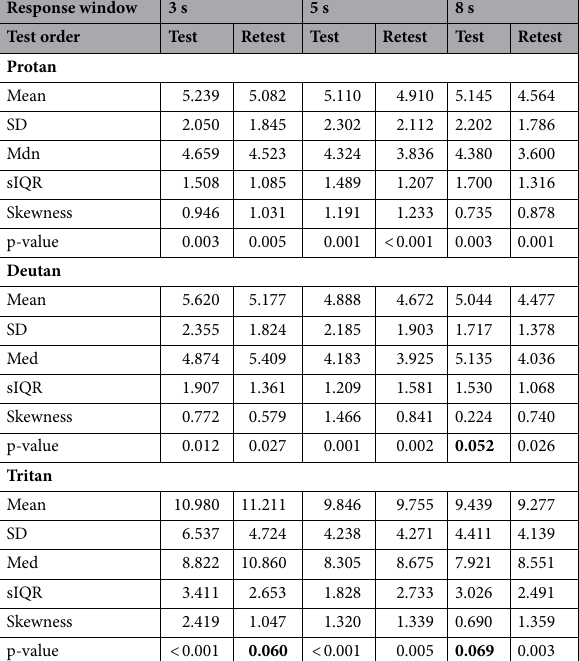
Table 1. Descriptive statistics of the Trivector measures (10 –5 u ′ v ′ units) for 3-s, 5-s and 8-s response windows, for test and retest, for the sample of normal trichromats (N = 30): Mean, standard deviation (SD), median (Mdn), semi-interquartile range (sIQR), and skewness. Outcomes of the Shapiro–Wilk test (p-value) indicate that the majority of data were not normally distributed; in three cases (indicated in bold) p-value was marginally significant.